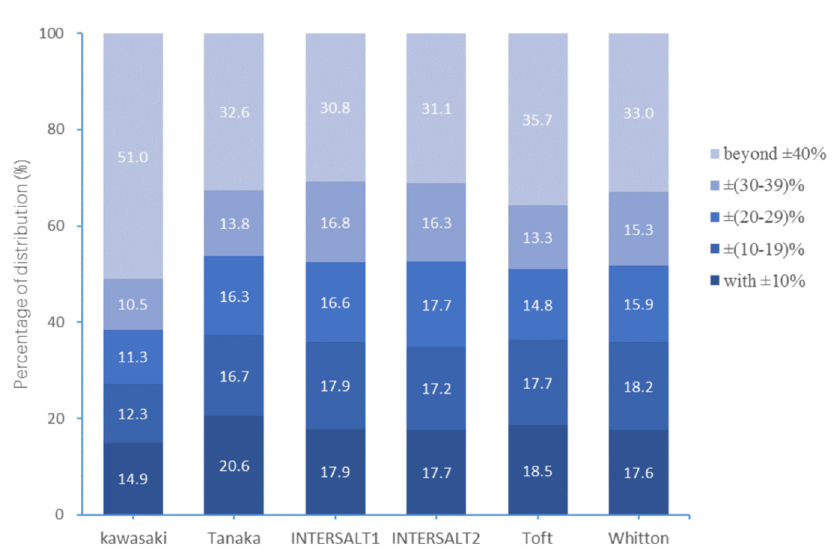
Figure 2. Relative difference distributions of measured and predicted 24-hUNa excretion.